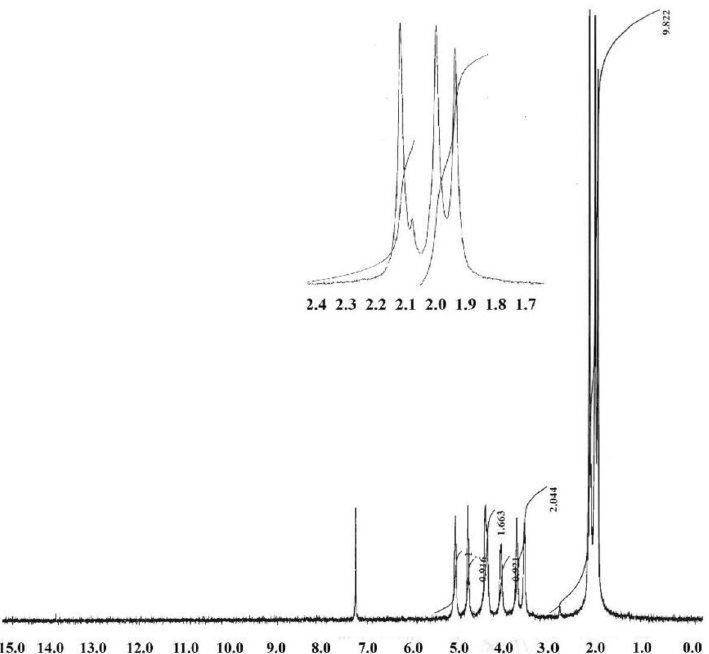
Figure 2. Cellulose tri-acetate 1H-NMR spectrum (DS = 2.82), Me stands for methyl protons in the acetyl group, H for anhydroglucose protons, and subscripts for Me or H positions on the